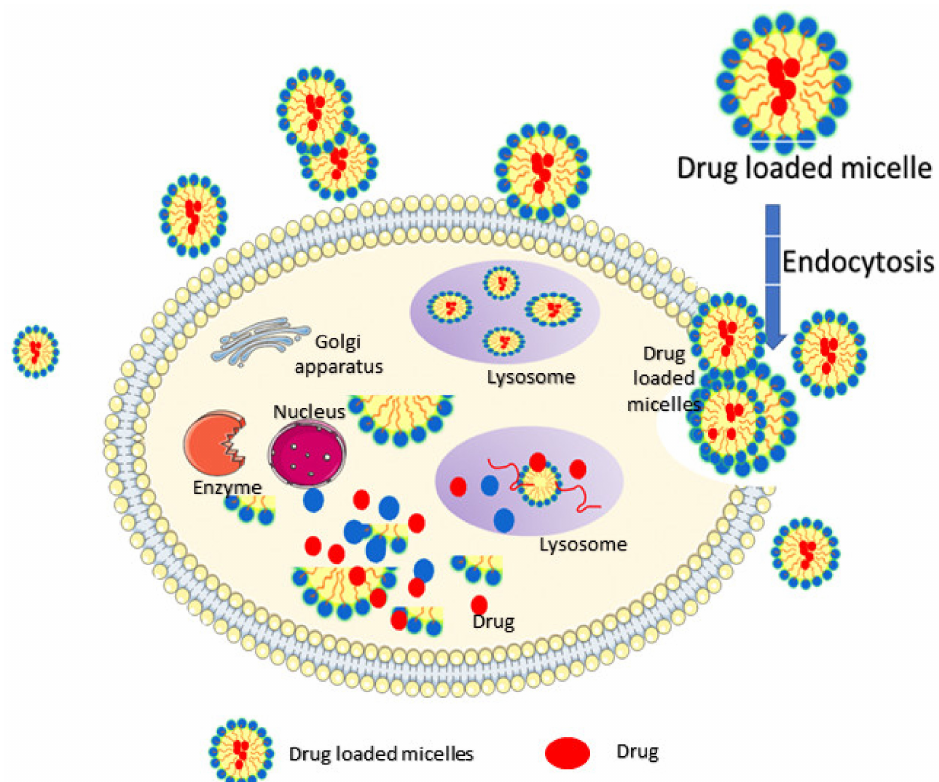
Figure 4. Polymeric micelle drug delivery concept.